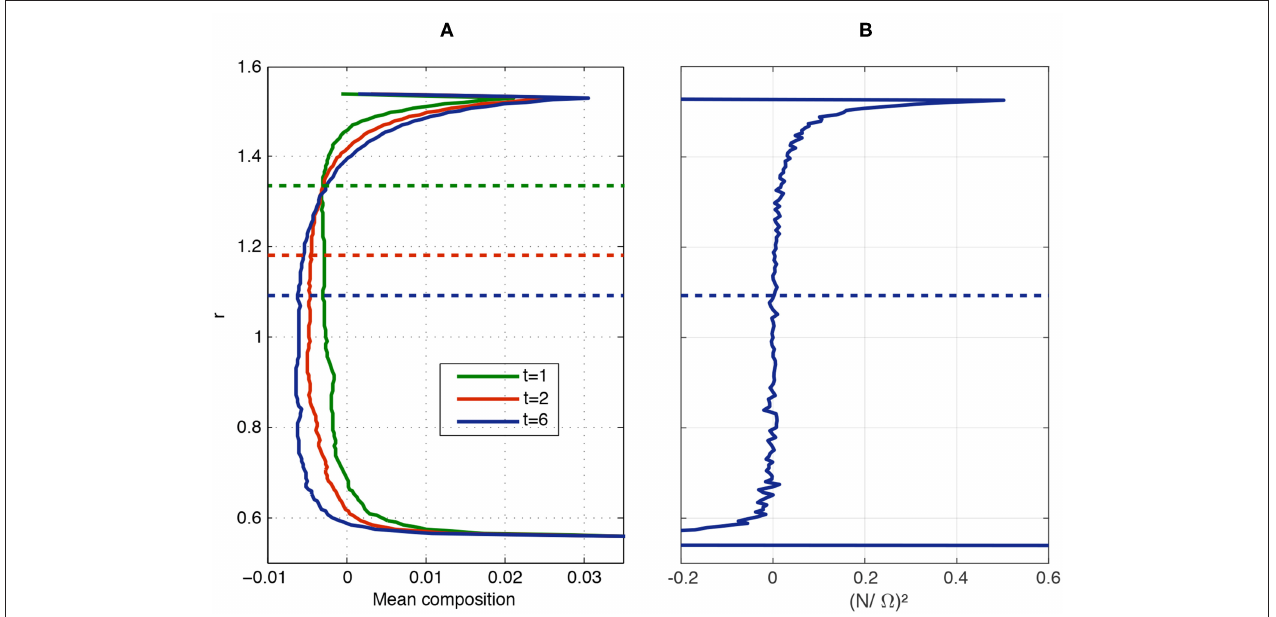
FIGURE 11 | (A) Radial profile of the mean composition at different times (in viscous time units) for case 1. The dashed lines indicate the bottom of the layer as defined by Equation (24). (B) ( N /(cid:127) ) 2 ratio at time t 6 for the same =